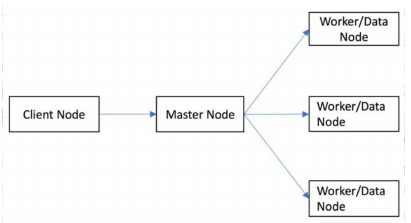
Figure 1. The general architecture for distributed data storage and